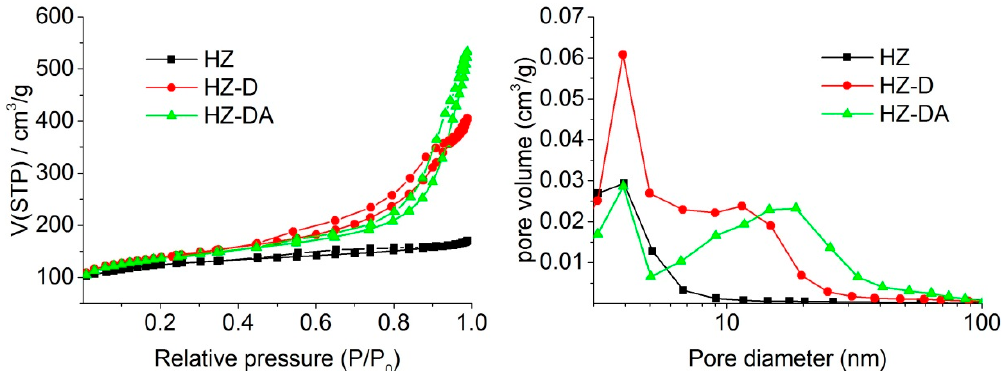
Figure 1. N 2 isotherms and the distribution of pore sizes of tested catalysts.